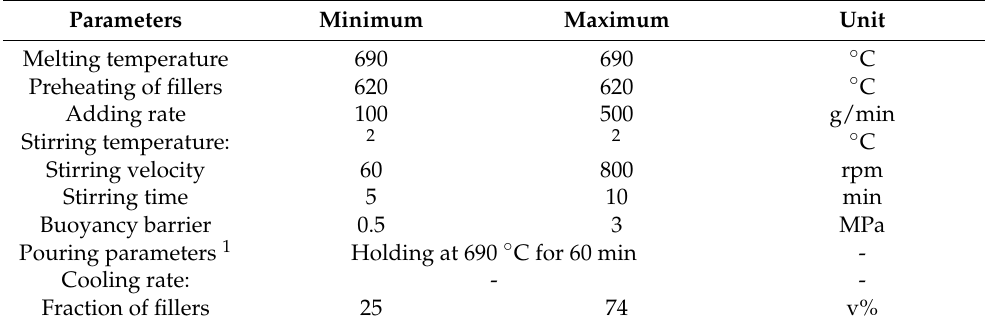
Table 3. Range of values of parameters governing modified stir casting, Route 1 (MSC-1)